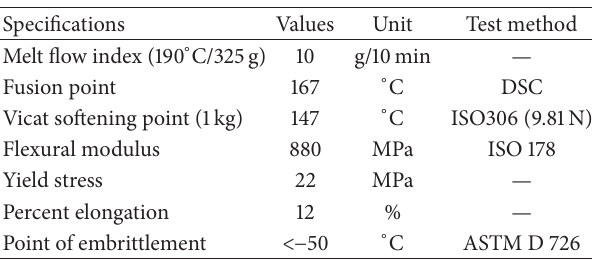
Table 3: Characteristics of the compatibilizer